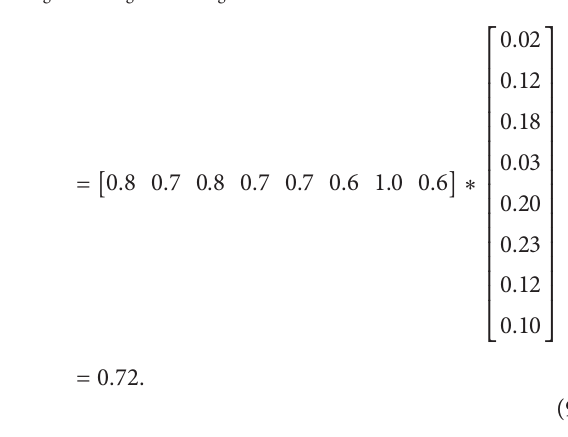
ability ( 𝑆 𝐽 ) of Puglia is proposed: = 𝐼 ∗ 𝑊 𝑆 Puglia Puglia